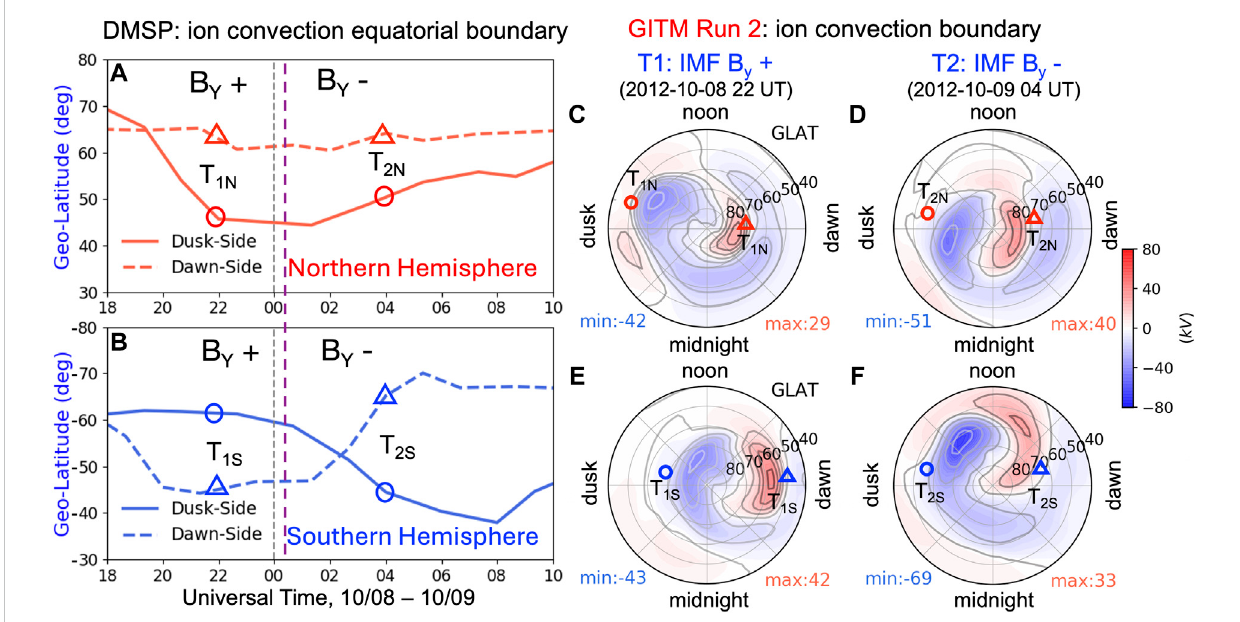
FIGURE 7 Theleftlinear fi gureshows thetemporalvariationsoftheionconvectionequatorial boundaryalongDMSPF16 ascendingtracks,i.e., duskside(solid lines) and descending tracks, i.e., dawn side(dashed lines) for both Northern [ (A) ,red lines] and Southern [ (B) , bluelines] Hemispheres. Thevertical purple dashed line marks the IMF B y reversal time from positive to negative at around 00:20 UT 9 October 2012. Snapshots of the FAC-driven convection patternsintheNorthern(topright)andSouthern(bottomright)hemispheresunderdifferentIMFconditions:IMFB y positive (C,E) ,22UTonOctober 8) and IMFB y negative [ (D,F) , 04 UT onOctober9]. The circle and triangle symbolsreferto theduskside and dawn side, respectively, under twodifferent IMF B y